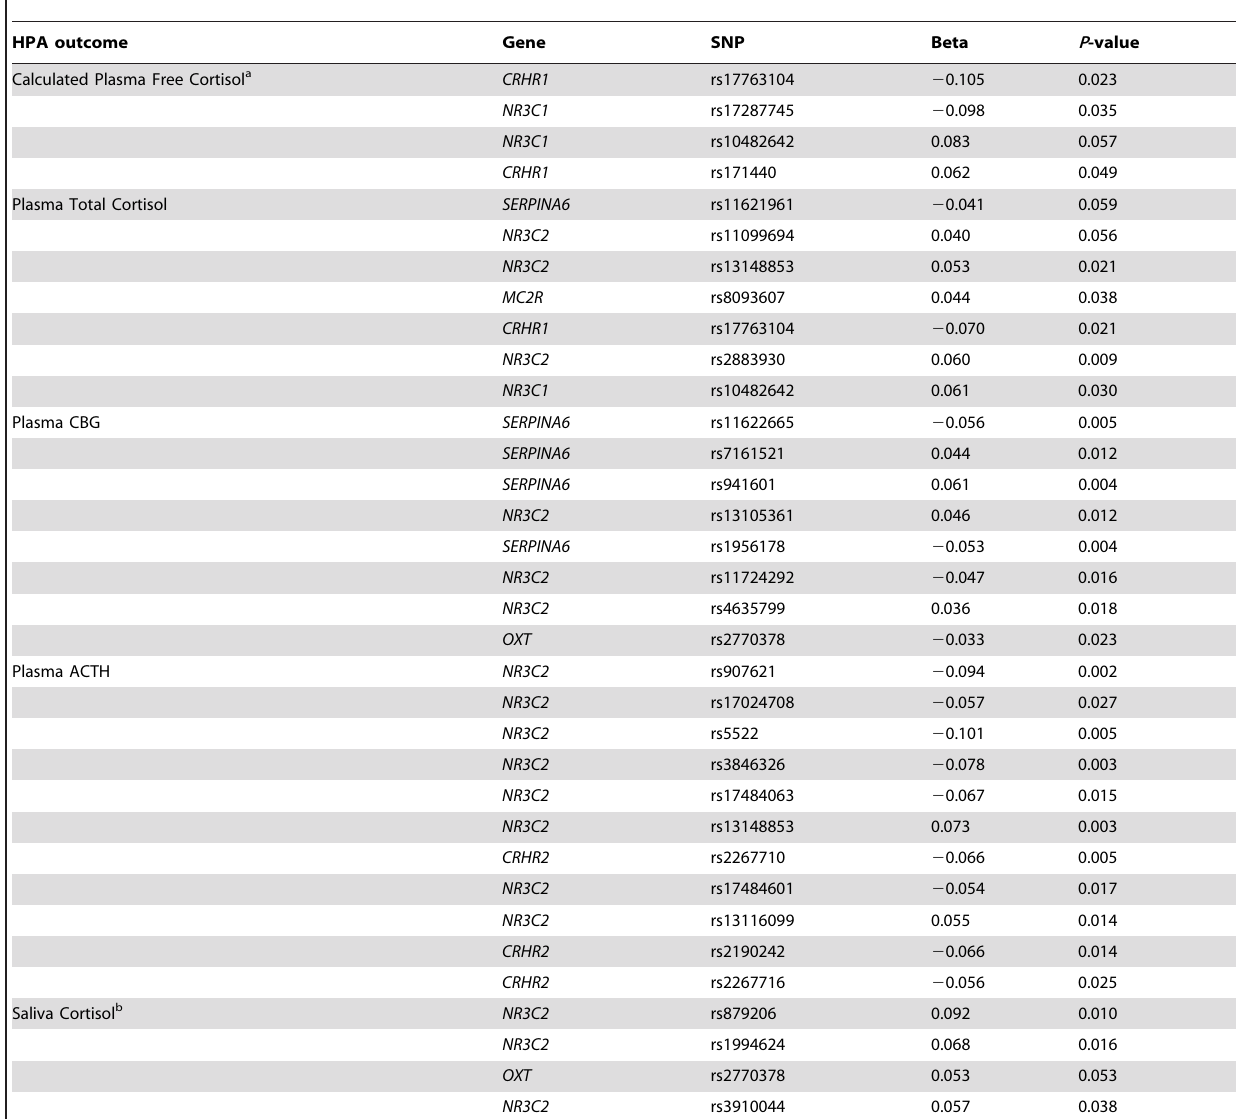
Table 3. SNPs associated with log transformed saliva and plasma HPA outcomes with p # 0.05 from multivariate linear regression analysis adjusted for BMI, blood draw time, sex and oral contraception